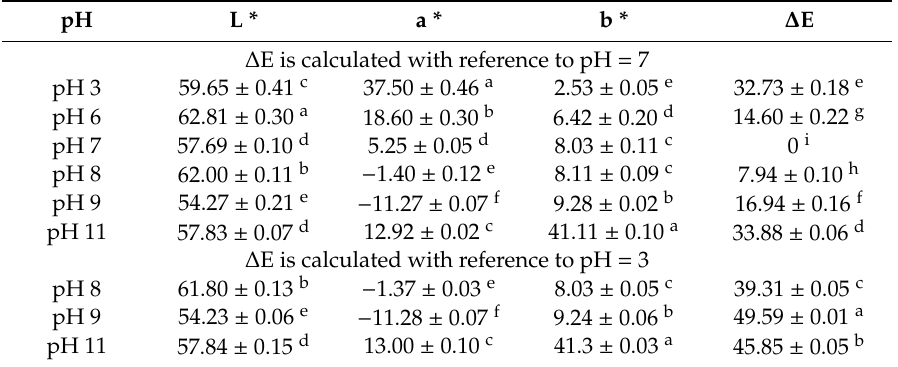
Table 3. Color parameters at di ff erent pH values for PVA-15 NCF crosslinked at 135 ◦ C for 15 min *.